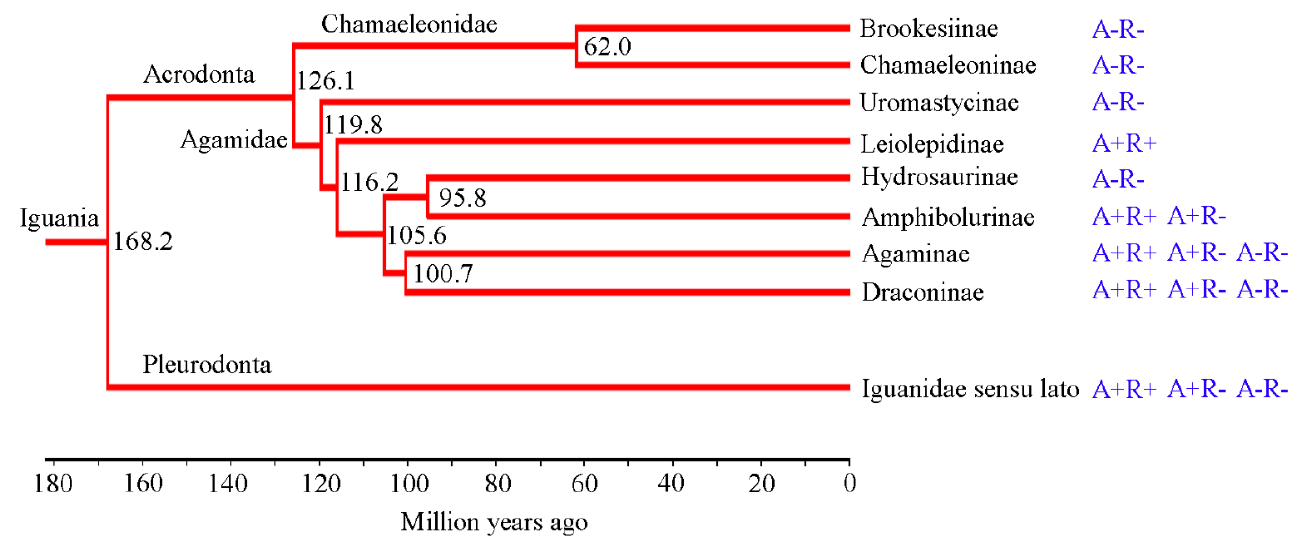
Figure 5. Phylogenetic tree of Iguania (combining phylogenomic and supermatrix approaches based on 52 genes and 4162 species for squamate reptiles) with a time calibration and indications of different types of autotomy and regeneration (after Zheng and Wiens [47] with modifications).